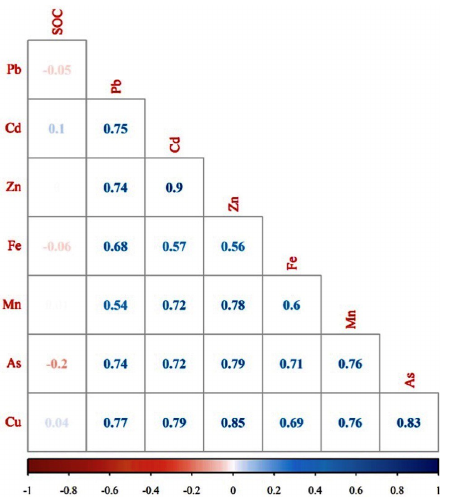
Figure 5. The Pearson correlation coefficients between soil PTEs, total Fe, and SOC.